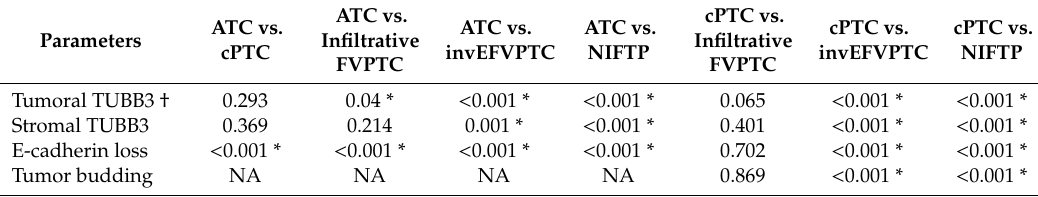
† Tumoral TUBB3 in H-score. * Statistically significant. ATC, anaplastic thyroid carcinoma; cPTC, conventional papillary thyroid carcinoma; FVPTC, follicular variant papillary thyroid carcinoma; invEFVPTC,